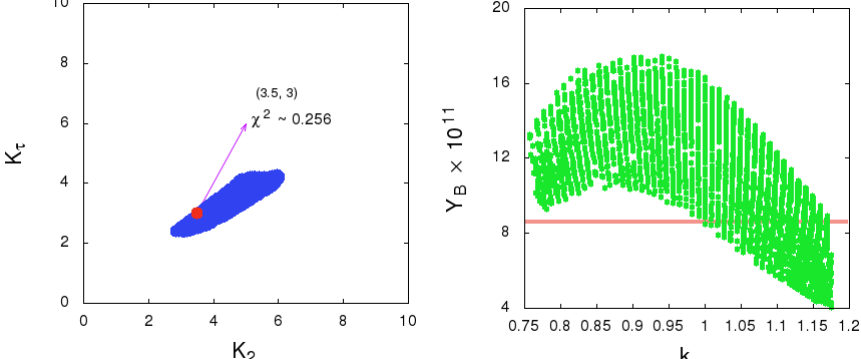
Figure 9 . The plot on the left hand side shows the range of the wash-out parameters. The red dot corresponds to the minimum value of (cid:31) 2 for which a set of primed parameter has been taken to compute Y B . The plot on the right hand side shows a variation of Y B vs k . The red band in the same plot indicates the observed range of Y B